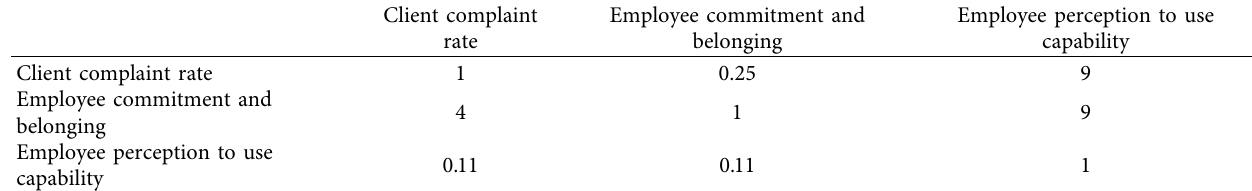
Table 5: Matrix of pairwise comparisons of criteria in the customer perspective.